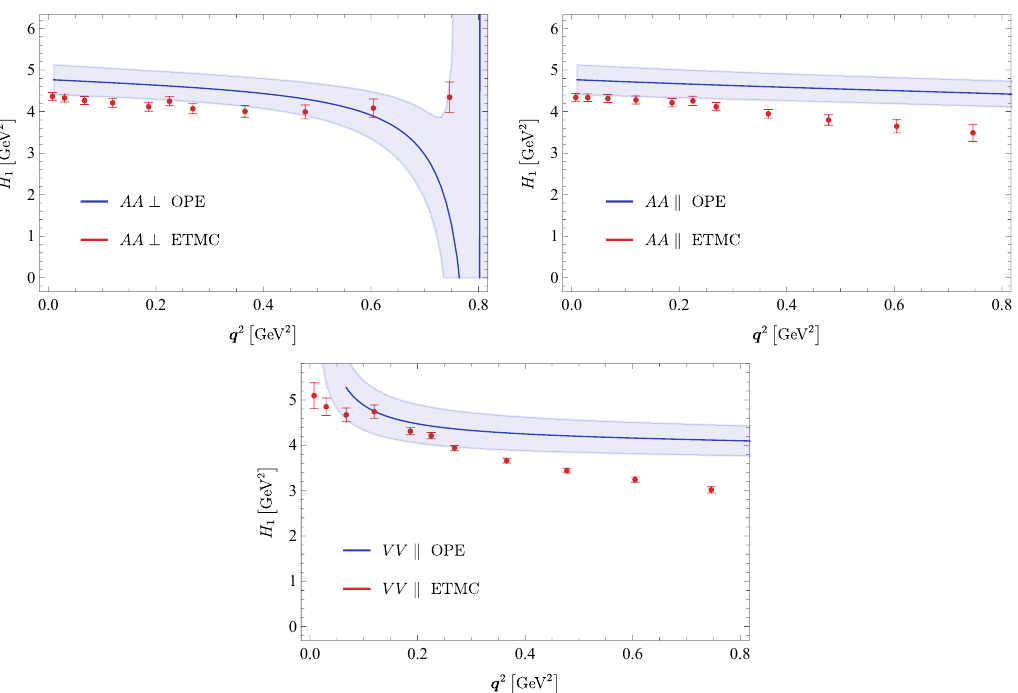
i ( q 2 ) in the various channels. The plots show the X